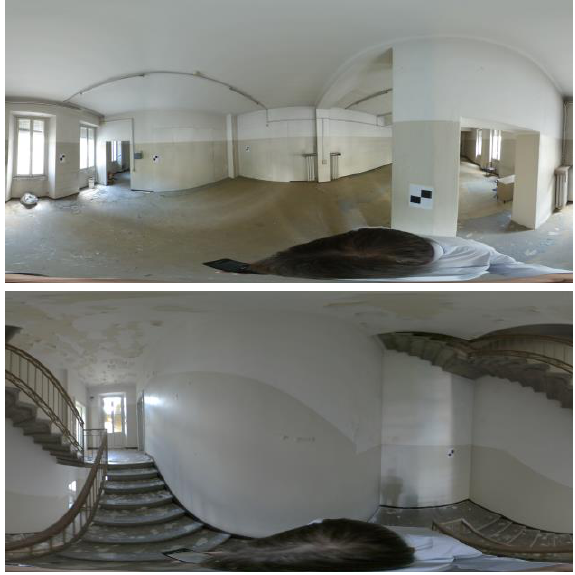
Figure 7. Some images of the sequence acquired between two floors.